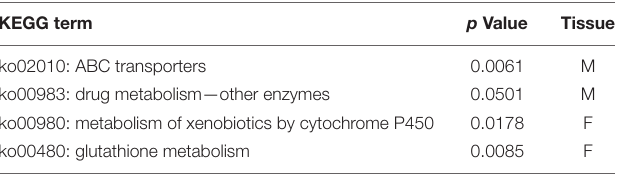
TABLE 2 | KEGG pathways containing genes differentially expressed in Midgut and Fat body.